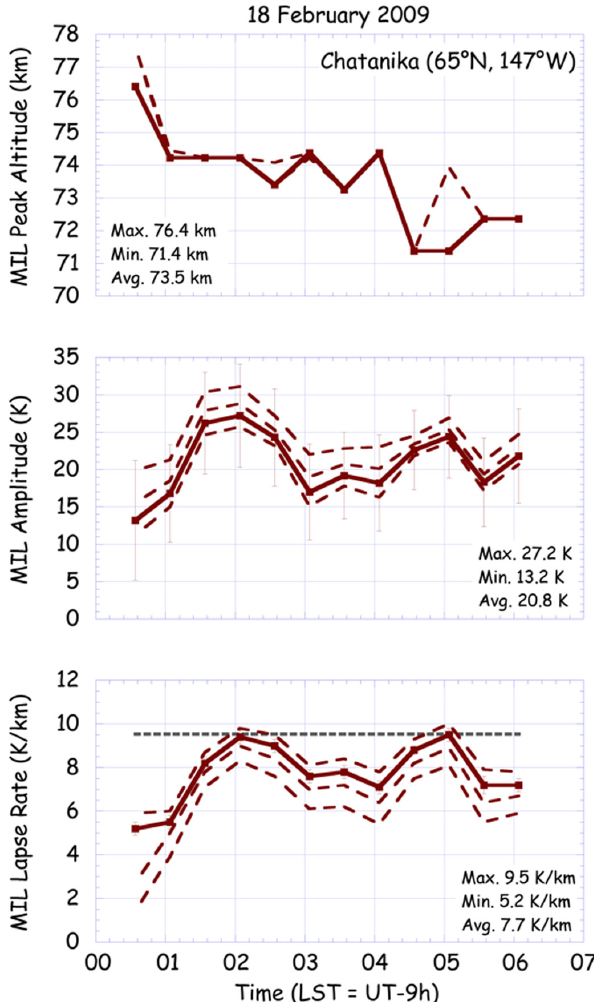
Fig. 2. Characteristics of mesospheric inversion layer (MIL) mea- sured by Rayleigh lidar at Chatanika Alaska on the morning of 18 February 2009 (solid thick line closed square). The values due to errors in the initial temperature at 82km (long dashed lines) are also plotted. Upper: Peak MIL altitude as function of local time. Middle: MIL Amplitude, as a function of time. The error bars are one-sigma uncertainties due to the statistical fluctuation in the lidar signal. Lower: MIL Lapse Rate as a function of time. The error bars are one-sigma uncertainties due to the statistical fluctuation in the li- dar signal. The dry adiabatic lapse rate is also plotted (short dashed line). The maximum, minimum and average values are